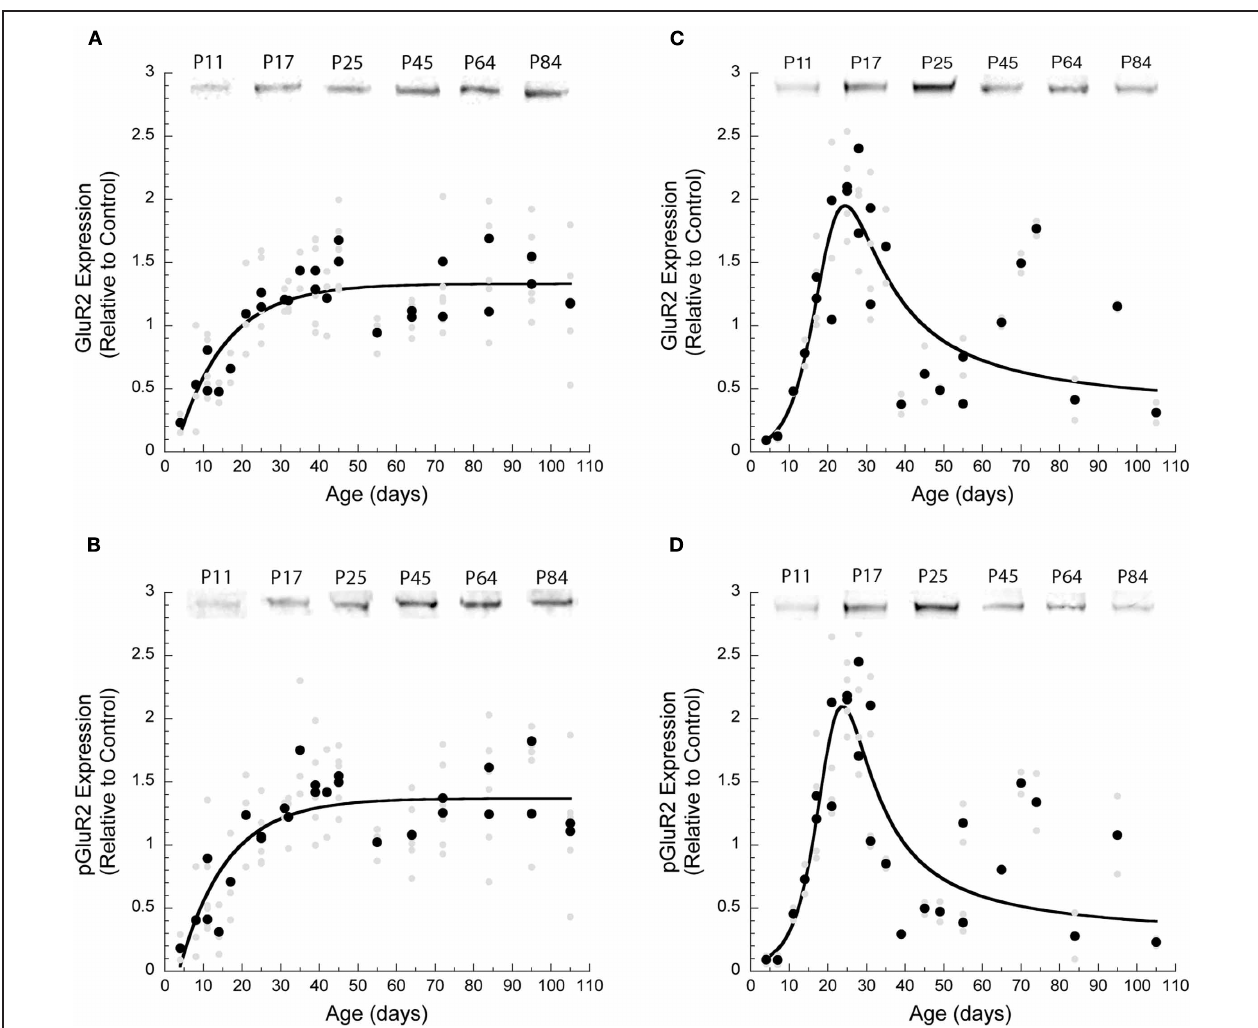
p < 0 . 0001) adult expression levels were reached at P38 (3 τ ); (B) pGluA2 expression ( R 2 = 0 . 68, p < 0 . 0001) reached adult levels by P36 (3 τ ). The results for frontal cortex were fit with a membrane transport function. (C) In frontal cortex: GluA2 expression ( R 2 = 0 . 77, p < 0 . 0001) had the maximum level at P24 (range P18–P35); (D) pGluA2 expression ( R 2 = 0 . 79, p < 0 . 0001) had the maximum level at P24 (range P19 and P32).